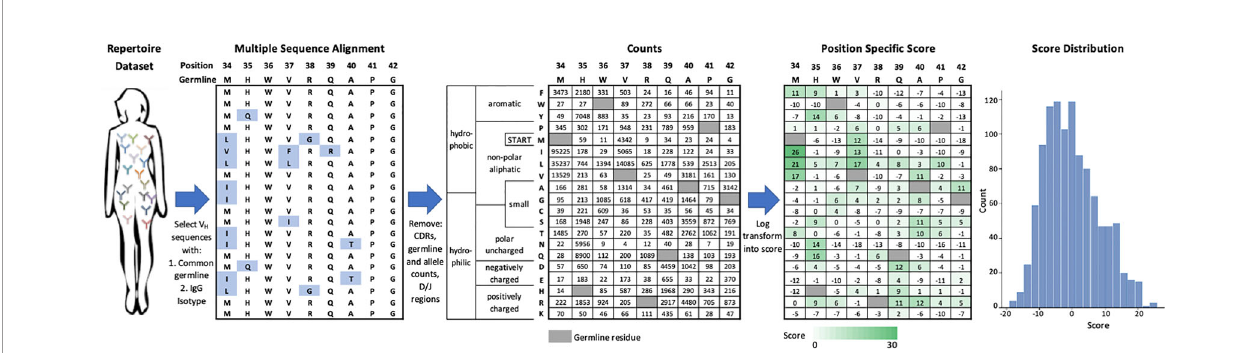
FIGURE 1 | Generation of V H germline position speci fi c scoring matrices. IgG sequences from a speci fi c V H germline are extracted from the repertoire dataset and aligned. Mutations from germline in V H framework regions are tabulated and then log-transformed into a position-speci fi c score. This score function centers the population of scores at zero with more frequent mutations indicated by a higher score. Data shown here is for the V H 1-2